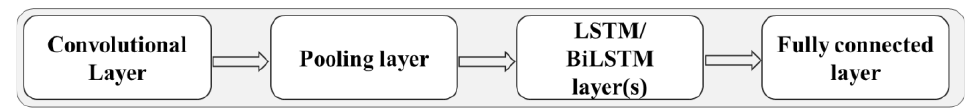
9 of 28 Figure 5. Block diagram of a convolutional neural network. 3.3.3. CNN-LSTM A CNN-LSTM model integrates the CNN model for feature selection with a Long Short-Term Memory (LSTM) model for time series prediction. A convolutional layer in this model identifies the important features in the input data [38]. Pooling reduces the data dimensions. The pooling layer interfaces with LSTM and linked layers (also known as dense layers). The combined CNN-LSTM model can be expressed as follows: ℎ 𝑡 = 𝐿𝑆𝑇𝑀(𝑥 𝑡 , ℎ 𝑡−1 ) (8) 𝑦 𝑡 = 𝐶𝑁𝑁(ℎ 𝑡